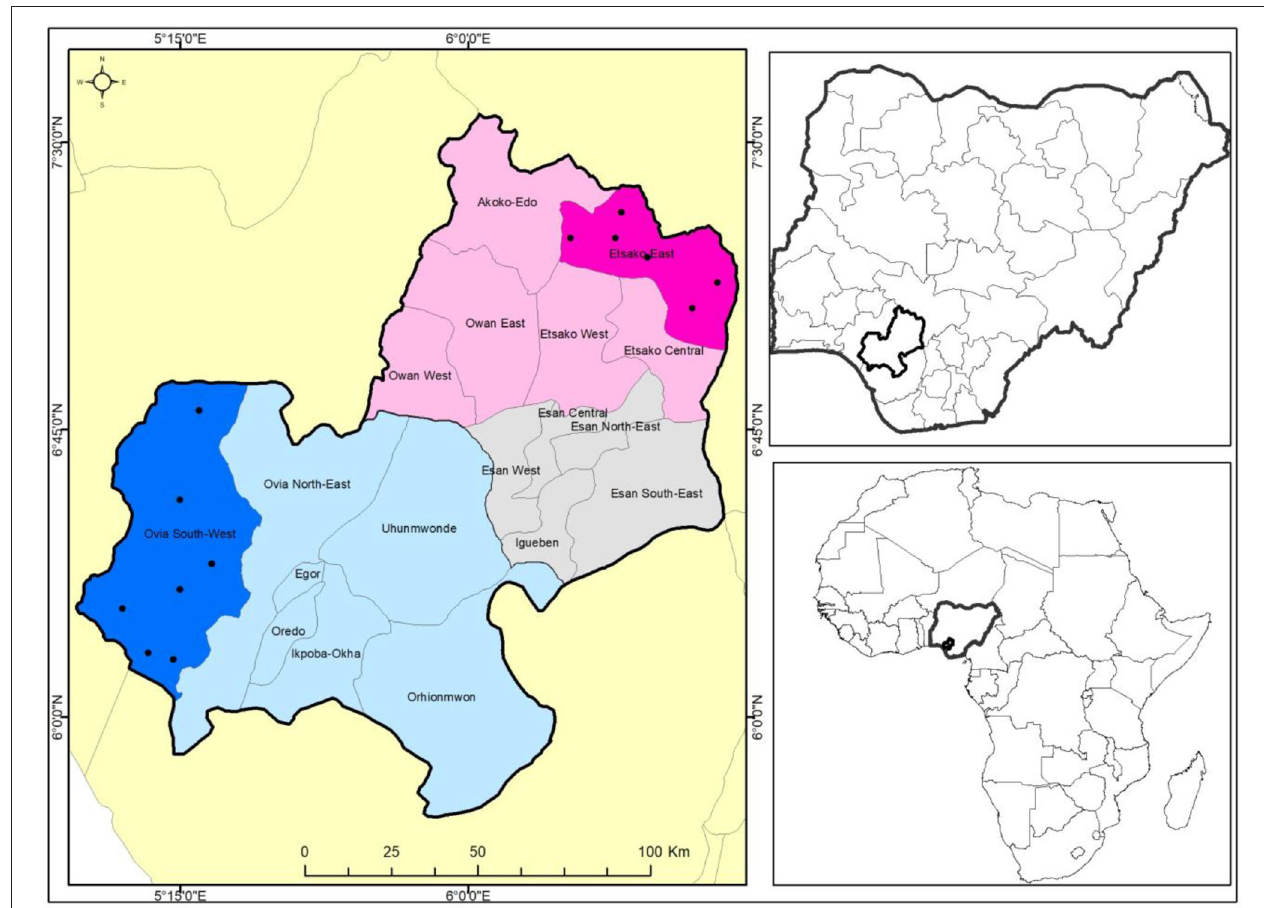
FIGURE 1 | Map of study area in Edo State of Central-Southern